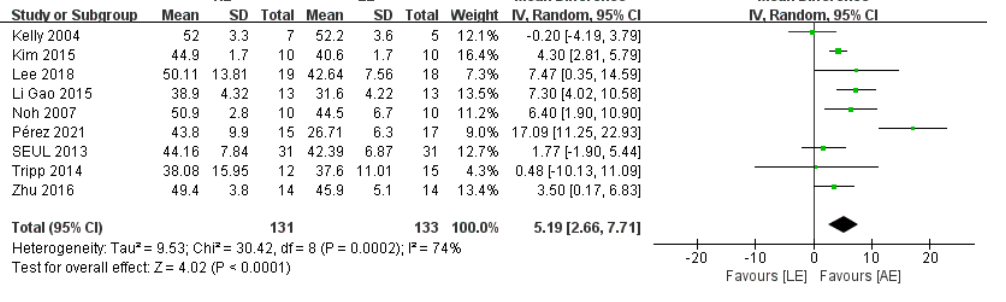
Figure 3. Forest plot: effects of BBS.